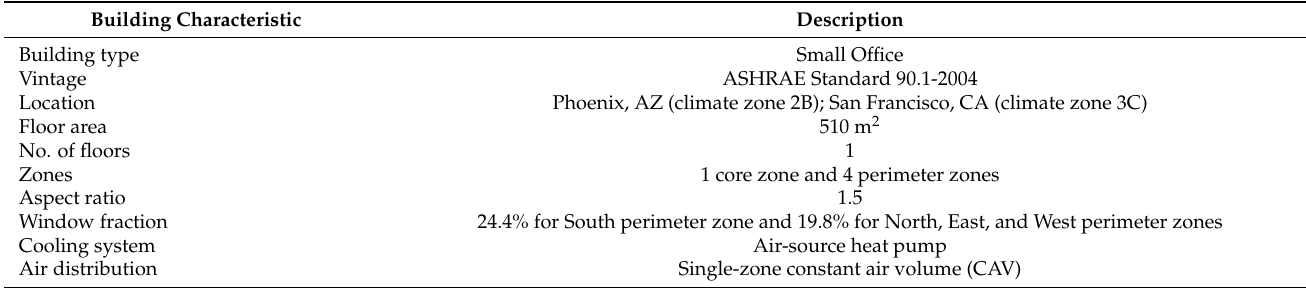
Table 2. Description of the DOE’s reference small office building model. Reproduced from [31], National Renewable Energy Laboratory: